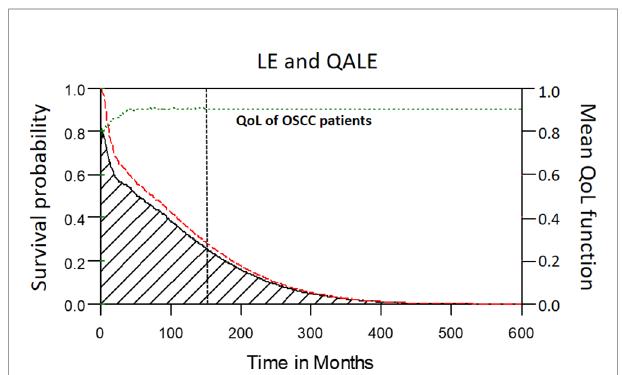
FIGURE 2 | The mean QoL (utility) function (green dashed line) was multiplied with the corresponding lifetime survival probabilities (red dashed line) to obtain the quality-adjusted survival curve (black solid line). The area under the red dashed line is the LE. The area under the black solid line is the QALE. The vertical black dotted line stands for the starting month of